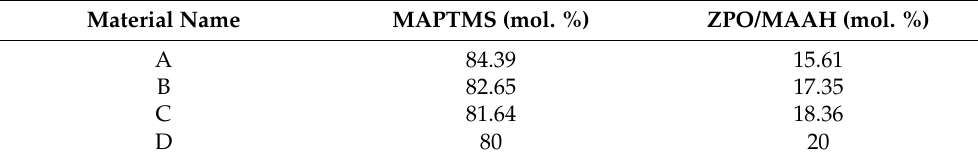
Table 1. Sol-gel formulations for the materials used in the fabrication of optical